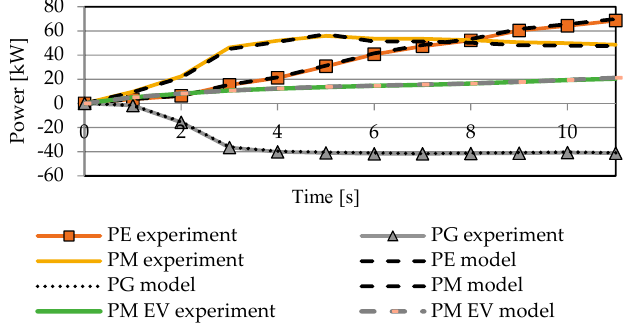
Figure 7. Power of the internal combustion engine, the electric motor and generator on time versus time.